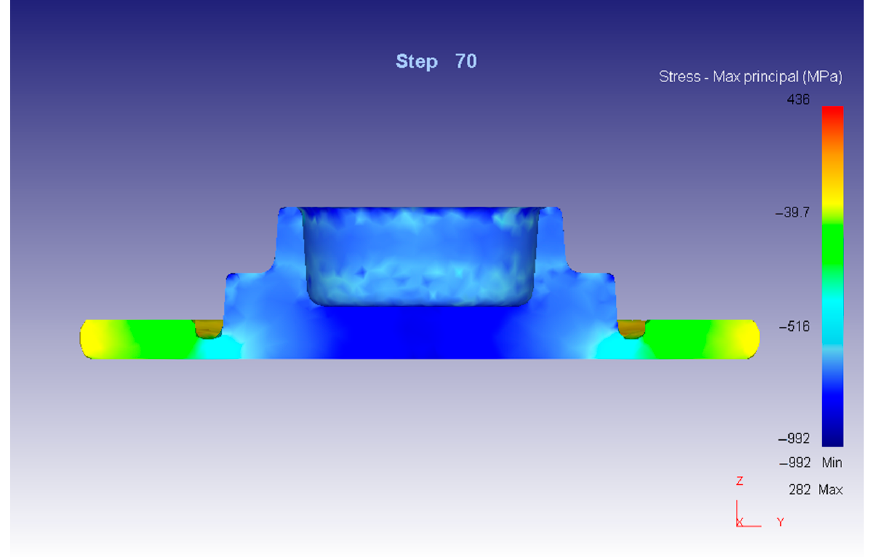
Figure 2. Diagram of the stressed state of the workpiece material at the end of the stamping pro- cess.